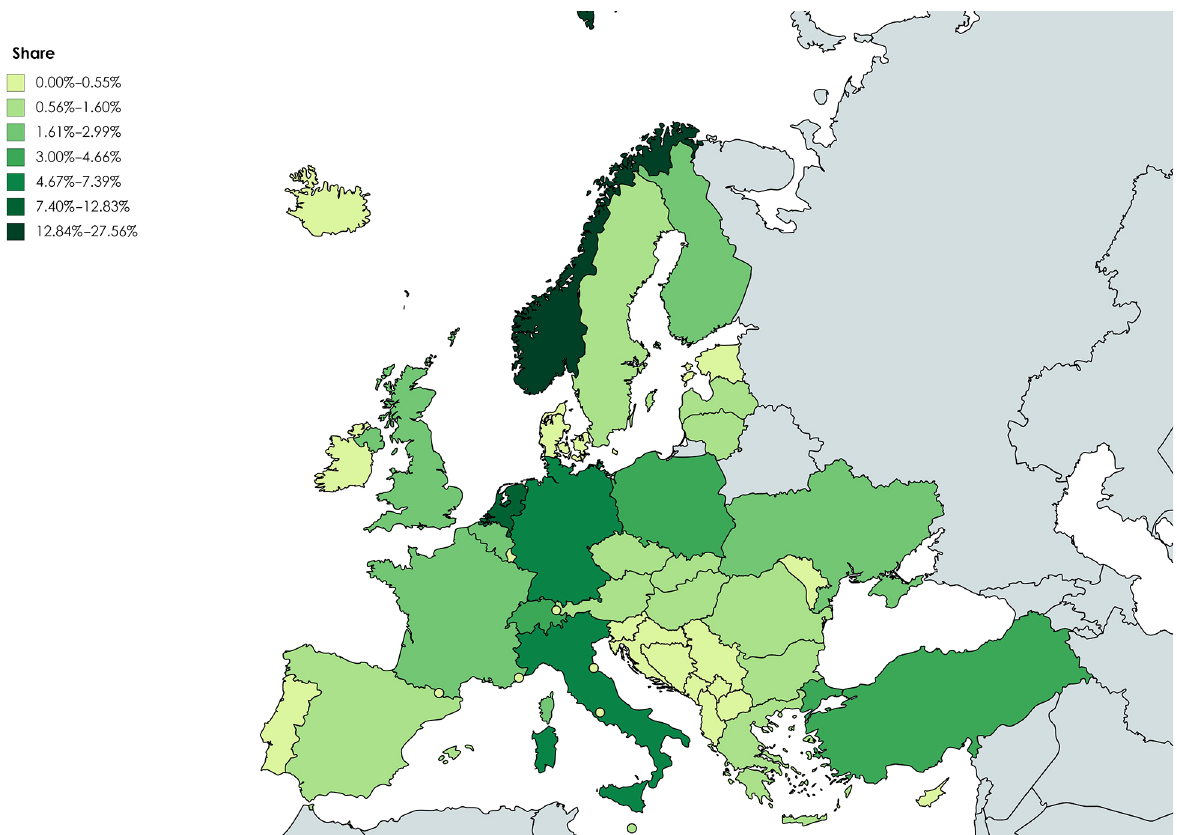
Fig. 6. Geographical structure of the EAEU merchandise exports to Europe in 2018. Source: own study based on the Eurasian Economic commission (n.d.).